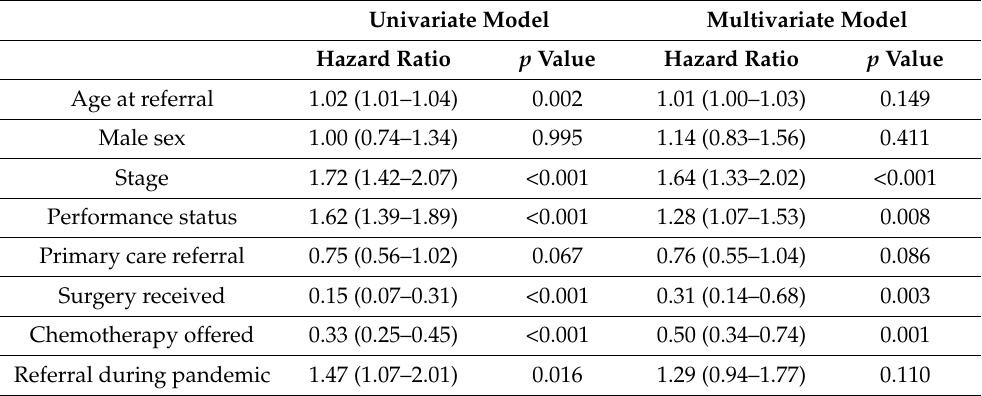
Table 3. Cox proportional hazards model for survival in patients diagnosed with